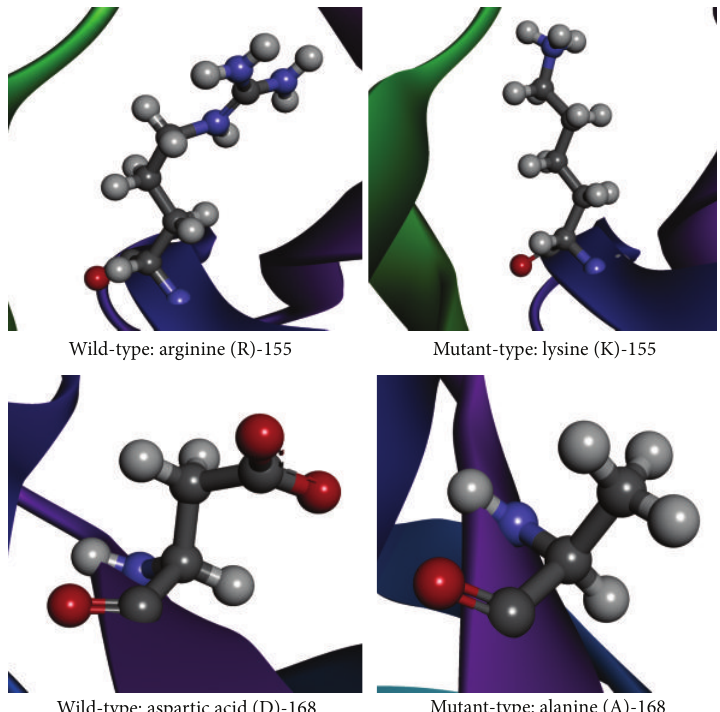
Figure 2: The figure depicts the native and mutated residues (shown in balls-and-stick model) of the variants R155K and D168A in the structure of NS3 protease (color rainbow). As can be inferred, the change in the residues introduced larger amino acid groups for R155K that will decrease the binding efficiency of drug molecules due to more steric hindrances. Also, the introduction of nonpolar groups for D168A transition will contribute to only weaker molecular interactions and thus reduced binding.